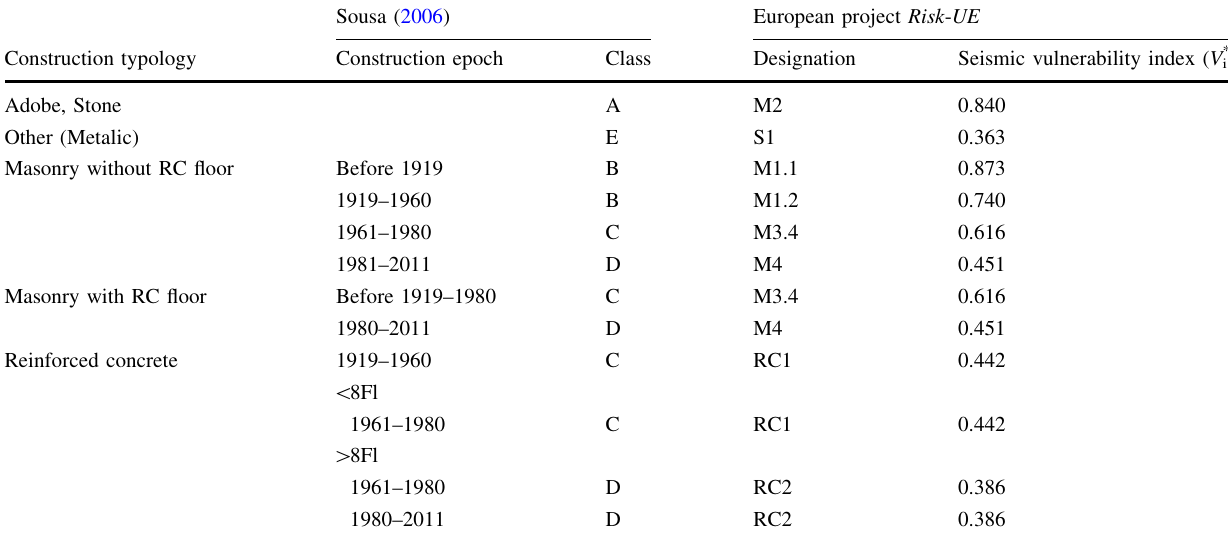
Table 5 Seismic vulnerability according to the pair construction typology/construction epoch Sousa